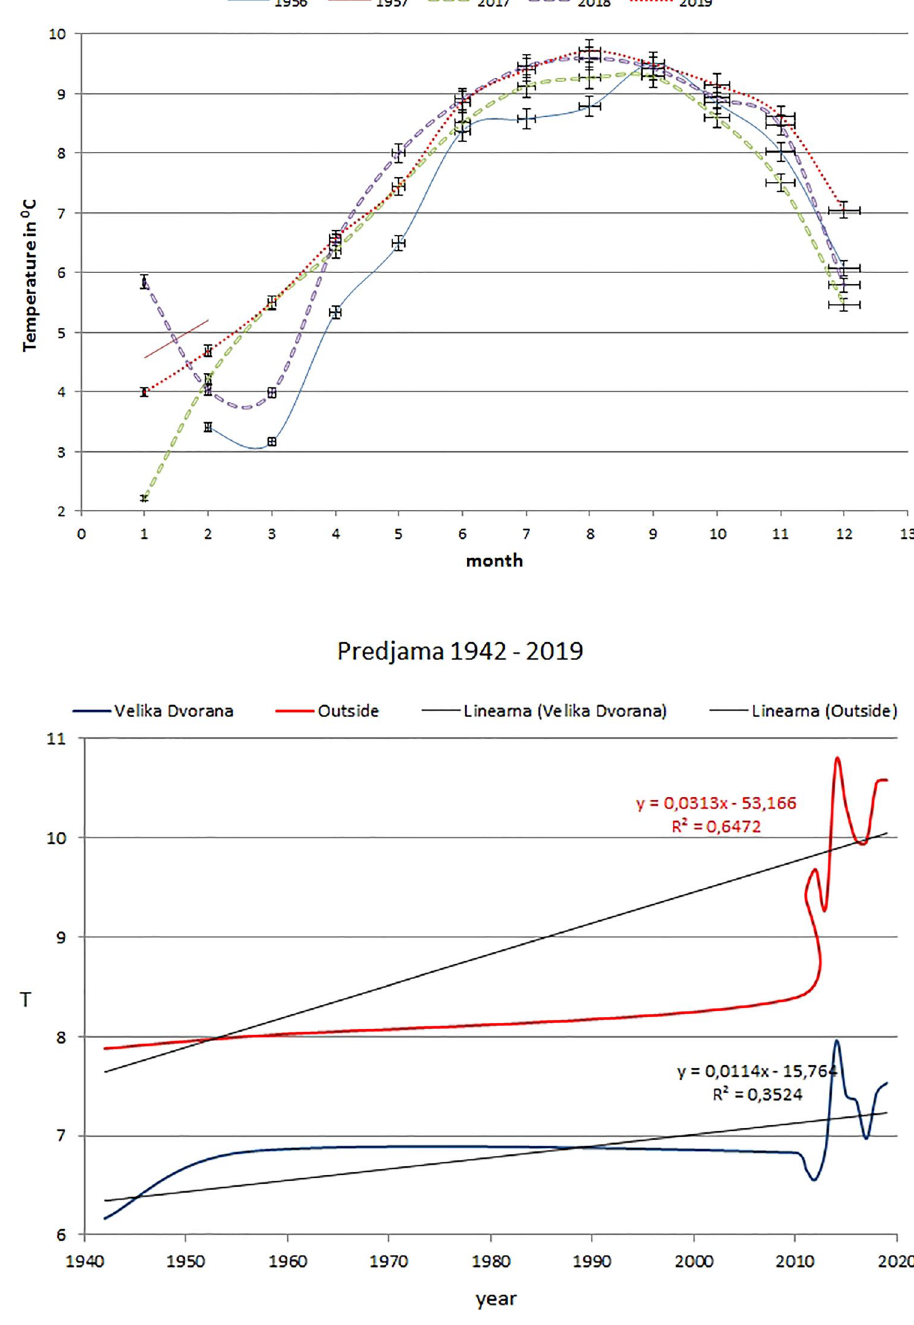
Fig. 5 Comparison of mean monthly historical [13] and current air temperatures (in °C) at Velika Dvorana in Predjama Cave, error bars show 2% standard error